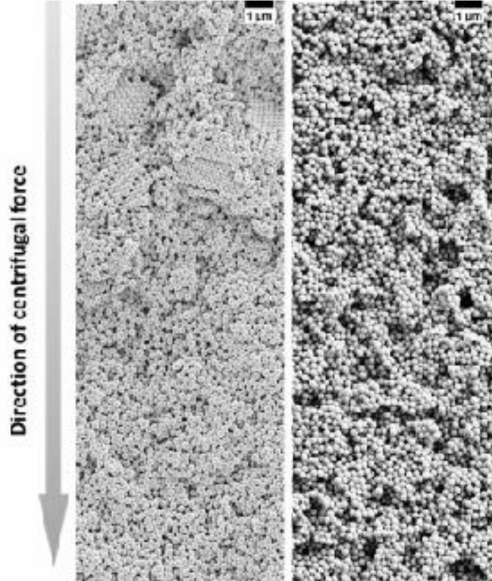
Figure 12. SEM images of colloidal glasses prepared in centrifugation in the presence of different salt concentrations. With a lower salt concentration, small crystalline domains can be still present in the upper part of the sediment (left panel) while at a higher salt concentration, the superstructure becomes totally disordered (right panel). Reproduced with permission from [144], Copyright Wiley- VCH,